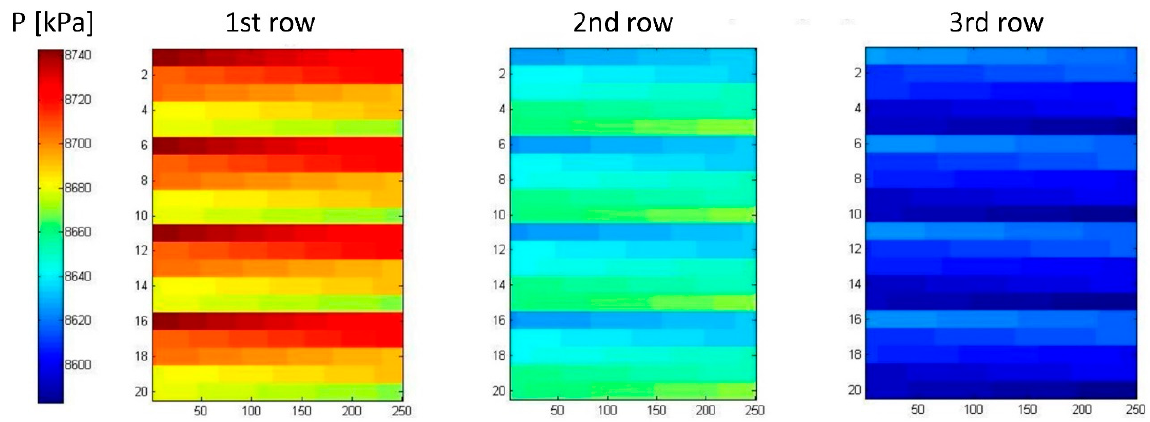
Figure 10. Pressure evolution of the refrigerant along the tubes of the gas cooler. The x -axis for each row represent the number of finned cells for each tube (shown on the y -axis). The figures lie on the x–z geometrical plane. The experimental distribution of the airflow was considered for the simulations.